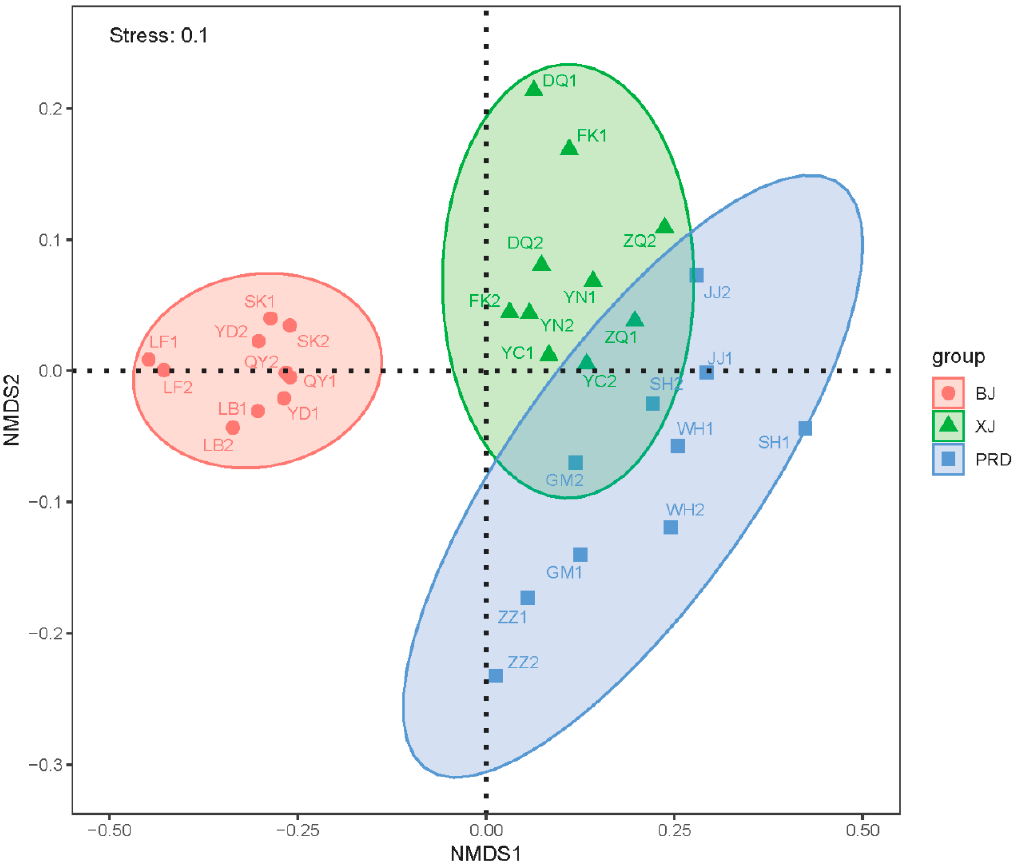
Figure 5. Nonmetric multidimensional scaling (NMDS) plots of bacterioplankton communities along the Pearl River based on the Bray–Curtis distance. Ellipses represent 95% confidence interval. Table 1. Analysis of similarity (ANOSIM) test of bacterioplankton communities based on Bray–Curtis distances among three tributaries of the Pearl River.